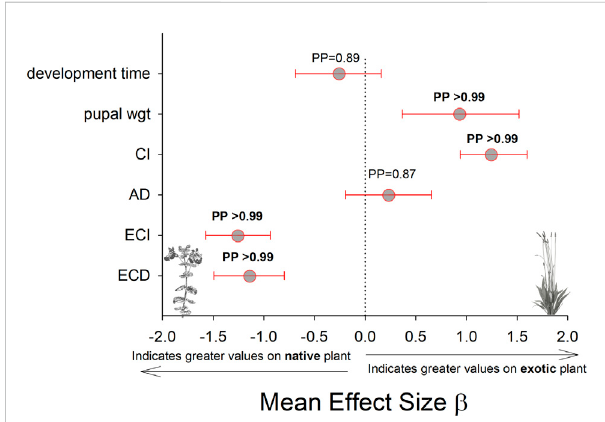
FIGURE 6 Comparison of development time, pupal mass, and feeding ef fi ciency measurements on the native host plant ( M. guttaus ) vs the exotic host plant ( Plantago lanceolata ). The mean effect size on the x -axis shows the difference in means between the two host plants for each response variable. The native host plant is used as the reference condition in each comparison, thus positive mean effect sizevaluesindicatelargereffectswhenrearedontheexotichostplant, and negative mean effect size values indicate larger effects when reared on the native host plant. All response values have been transformedtoz-scores.Bayesianposteriorprobabilities (PP)and95% highest posterior density intervals (HPDI) are shown. CI = consumptionindex,AD = approximate digestibility,ECI= ef fi ciency of conversion of ingested food, ECD = ef fi ciency of conversion of digested food.